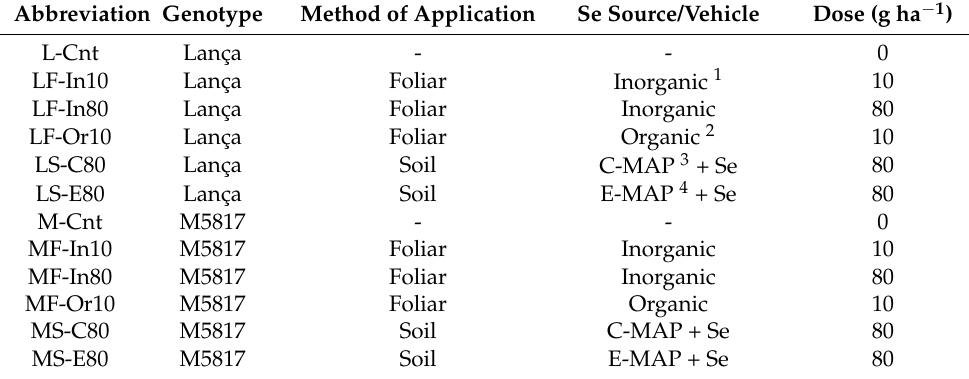
Table 1. Treatments description applied in soybean